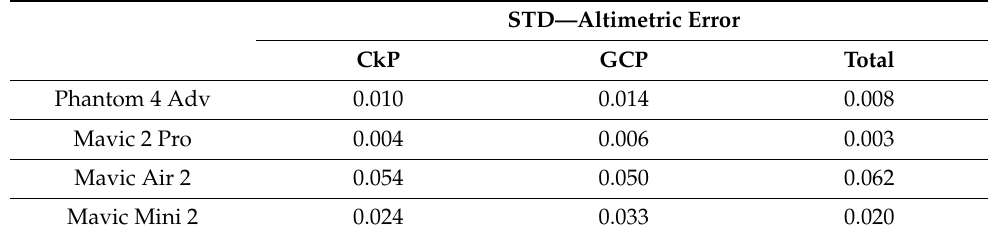
Table 11. Standard deviation calculated for the altimetric error.